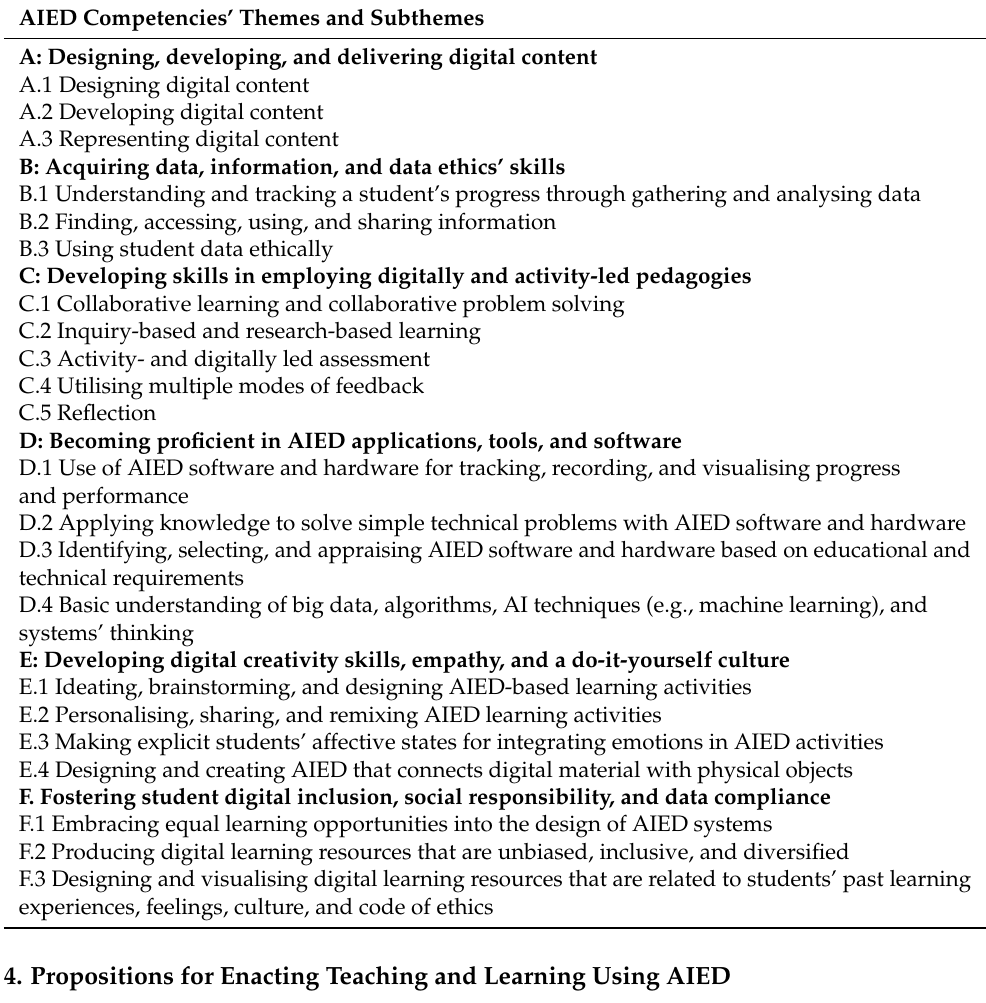
Table 6. The AIED Comp: Teachers’ digital competencies of teaching and learning using